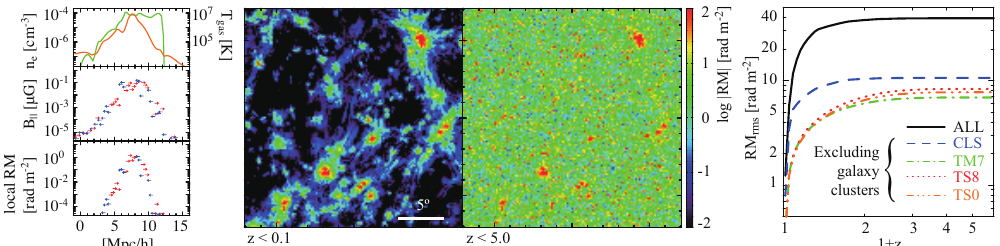
Figure 1. ( Left ) One-dimensional profiles of the electron density n e (green), the gas temperature T gas (orange), the line-of-sight component of the intergalactic magnetic field (IGMF) B || and the local rotation measure (RM) for a 195-h − 1 kpc spatial resolution, through a typical filament in the local Universe. Here, h is the Hubble parameter. The arrows indicate the signs of B || and the local RM [37]. ( Middle ) RM maps of 200 deg 2 considered up to z < 0.1 (the local Universe, left) and z < 5 (right). ( Right ) Redshift evolution of the rms value of RM. The average for 200 (runs) × 2048 2 (pixels in 200 deg 2 ) is shown. Except ALL, galaxy clusters were excluded from the integrations using different criteria (CLS, TM7, TS8and TS0)